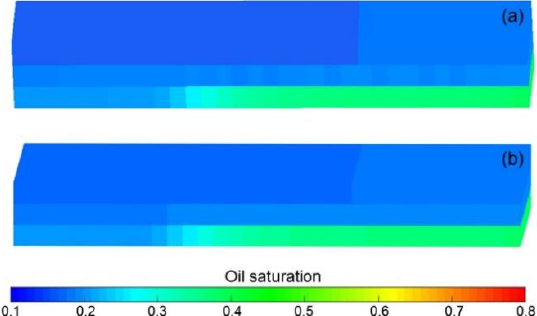
Figure 11. Comparison of 3D remaining oil saturation distributions after cumulative injection volume of 2.4 PV based on ( a ) ECLIPSE V2013.1 software and ( b ) the designed simulator for running Case 1.